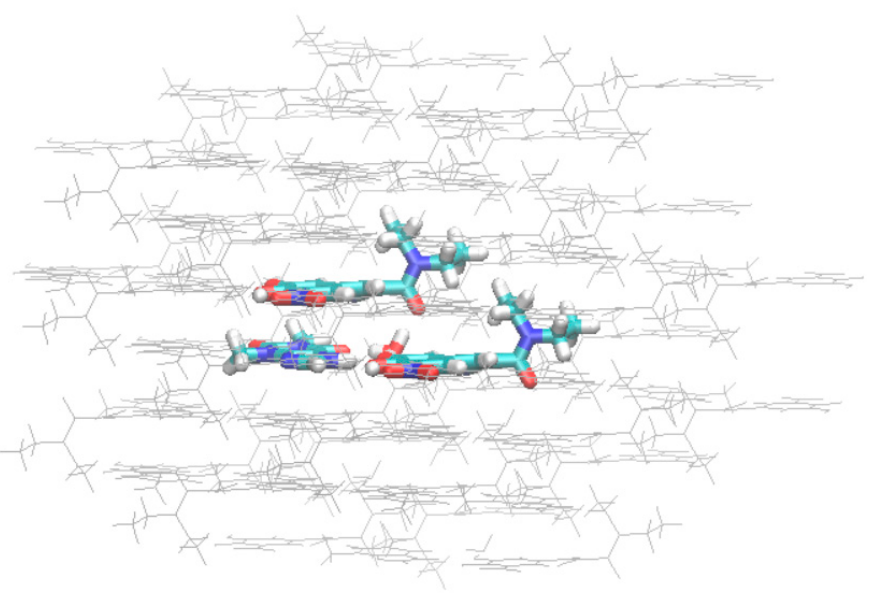
Figure 8. Molecular cluster of QM/MM computations with the central complex of four hydrogen bonded molecules.